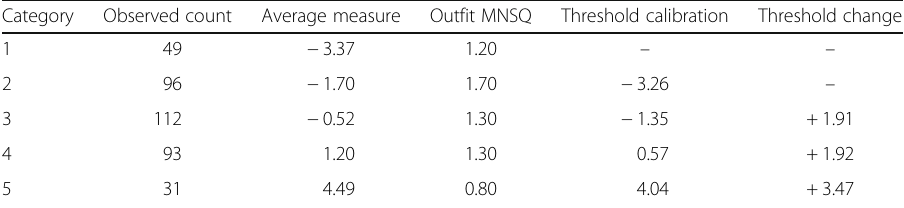
Table 5 Summary of the category structure for the 5-point interaction rating scale